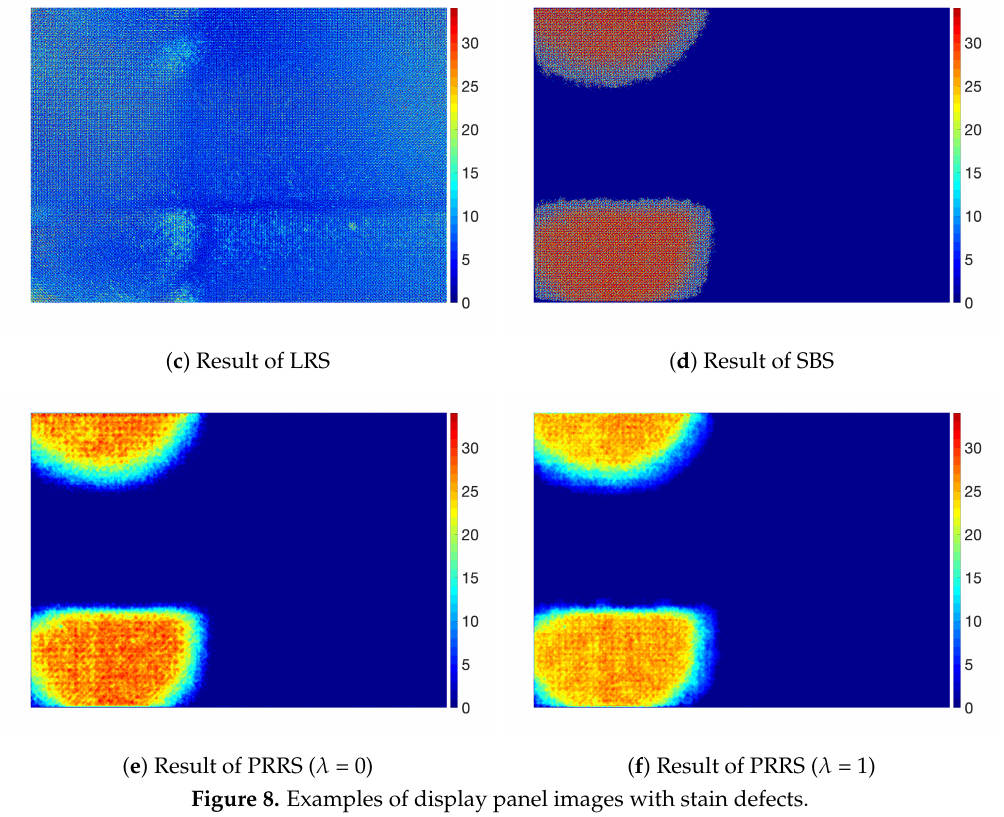
Figure 8. Examples of display panel images with stain defects.